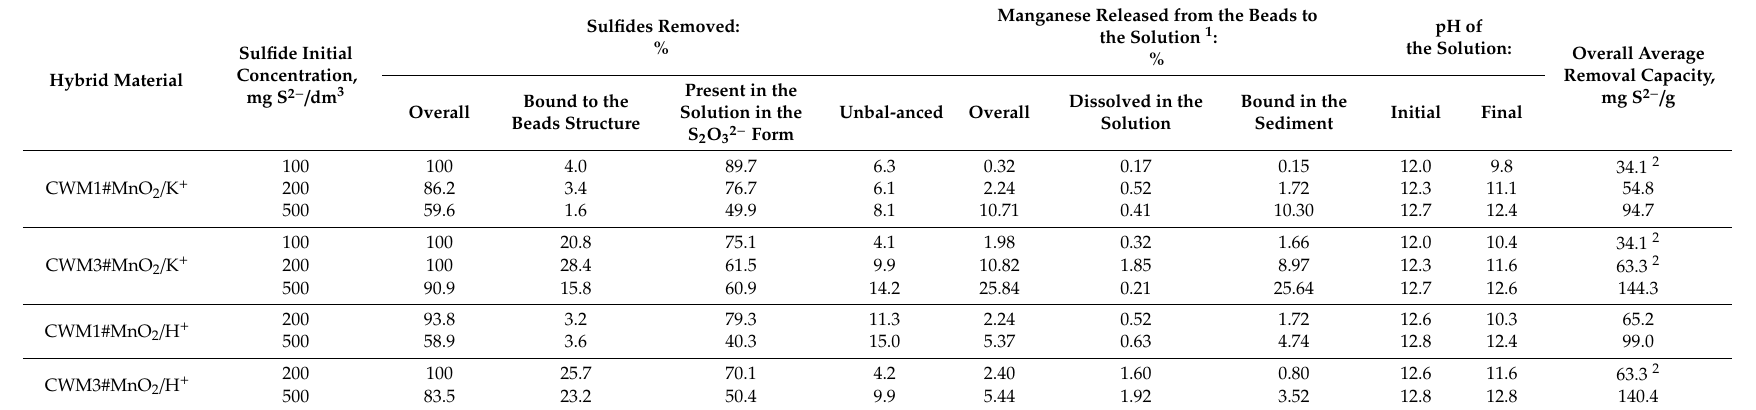
Table 5. Mass balance of sulfide removal process with examined hybrid materials; on average, n = 3, RSD ≤